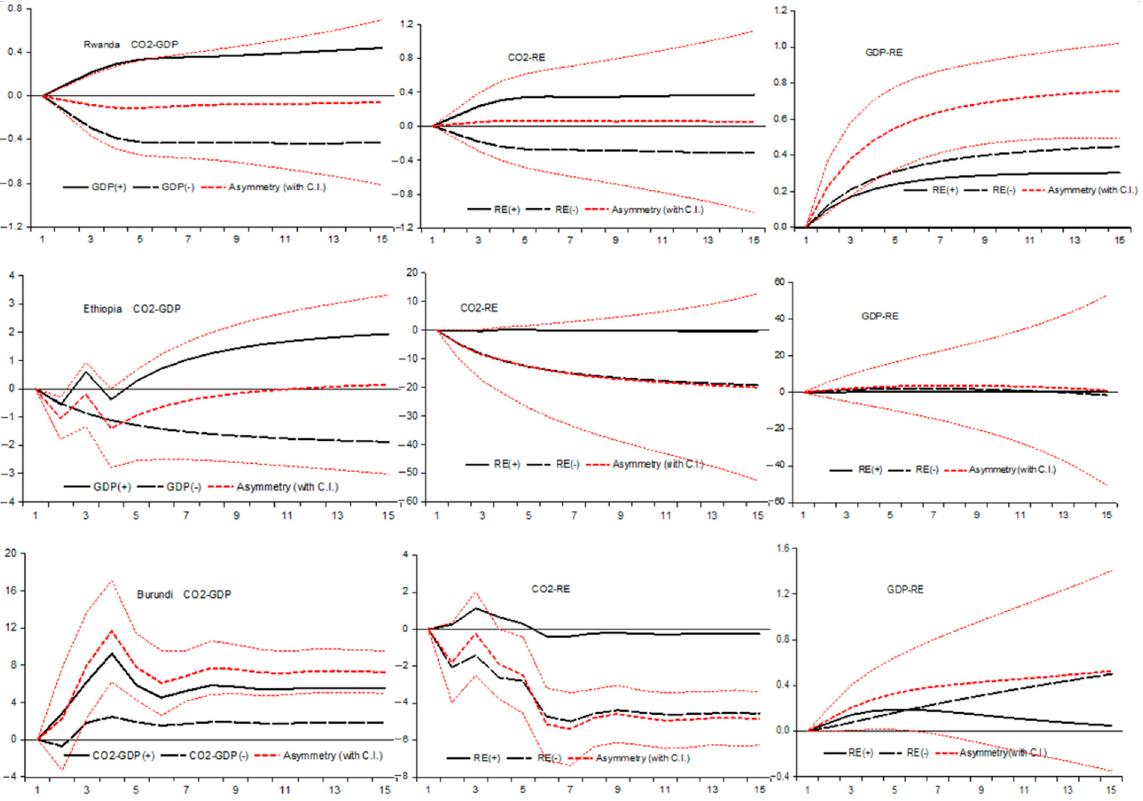
Figure 2. Dynamic multiplier plots of the nonlinear asymmetric and symmetric relationship between CO 2 emissions and GDP, CO 2 emissions and renewable energy, and GDP and renewable energy in Rwanda, Ethiopia, and Burundi.